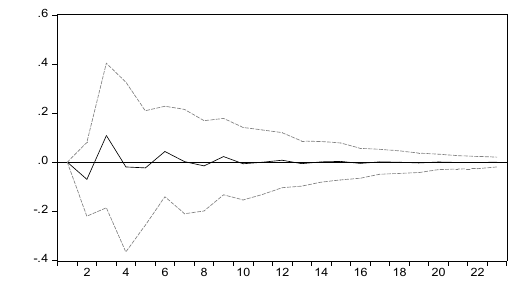
Figure 5. Response of CAP to